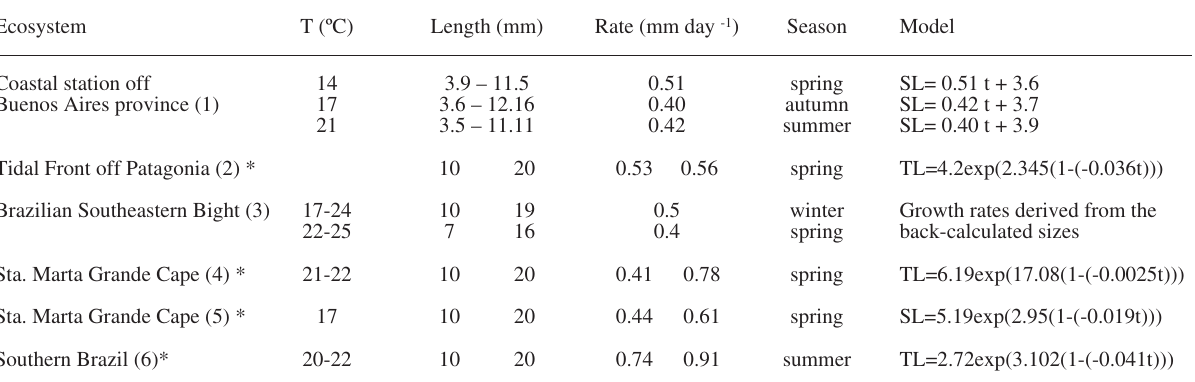
Table 2. – Growth rate comparison for Engraulis anchoita larvae of SW Atlantic. T: temperature, TL: total length, SL: standard length, t: days. (1) This work; (2) Brown and Sánchez, in press; (3) Castello and Castello, 2003; (4) Kitahara and Matsuura, 1995; (5) Castello and Vas- concellos, 1995; (6) Ekau, 1998; * Instant growth rate obtained by deriving the Laird-Gompertz model with respect to larval sizes (10, 20 mm).